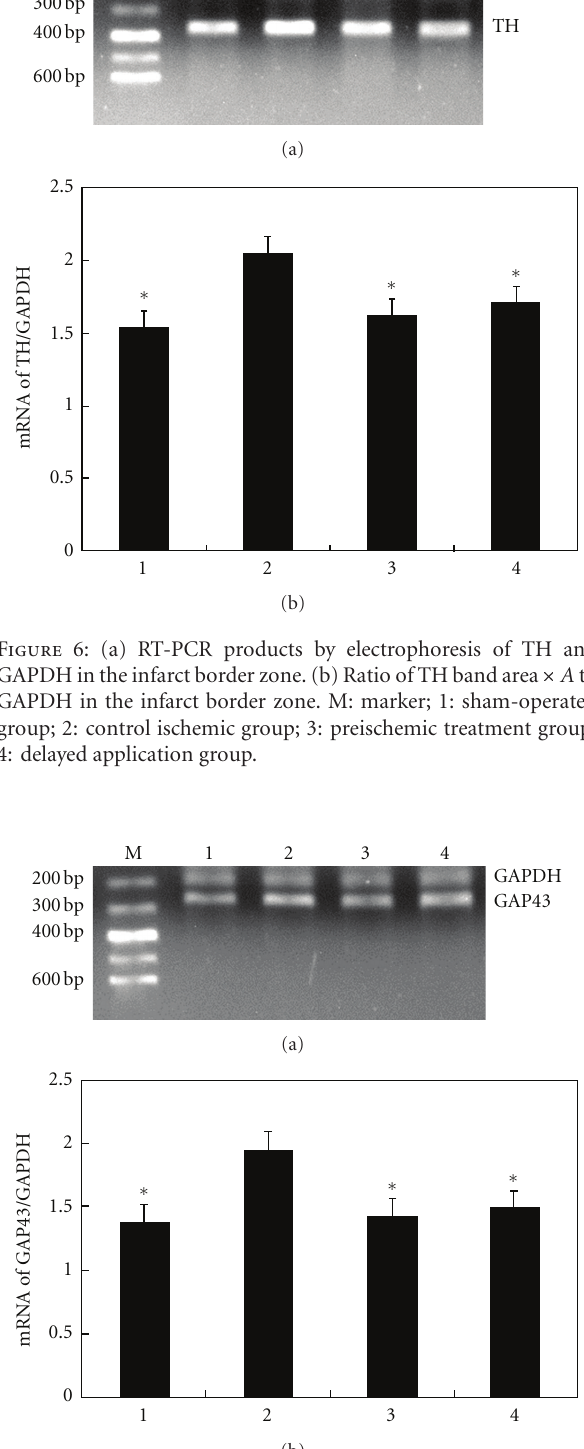
(cid:2) A to GAPDH in the infarct border zone. M: marker; 1: sham-